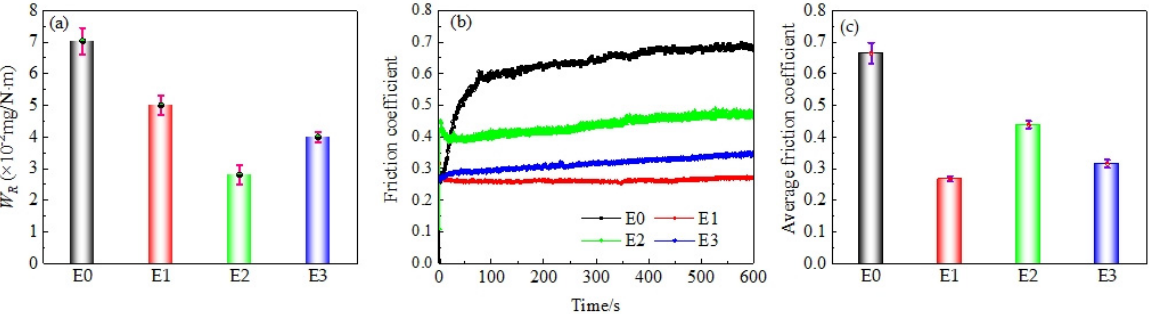
Figure 7. Variation of wear rate and friction coefficient of E0, E1, E2 and E3 samples. ( a ) Wear rate; ( b ) friction coefficient vs. time; ( c ) average friction coefficient. ( b ) friction coefficient vs. time; ( c ) average friction